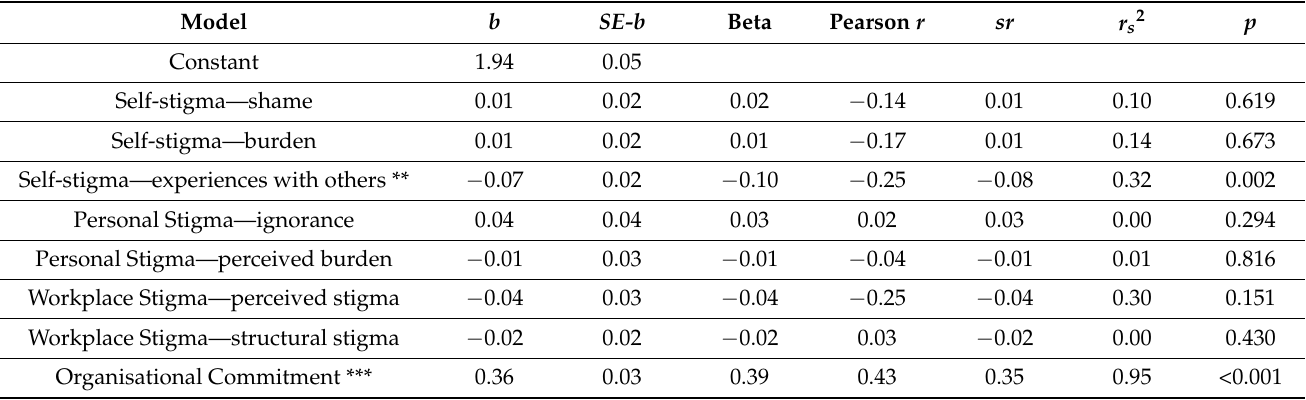
Table 5. Standard Multiple Regression Results for Self-stigma, Personal Stigma, and Workplace Stigma Predicting Police and Emergency Service Personnel’s Reported Fair Treatment a Going Through the Claims Process for Psychological Injuries. b SE-b